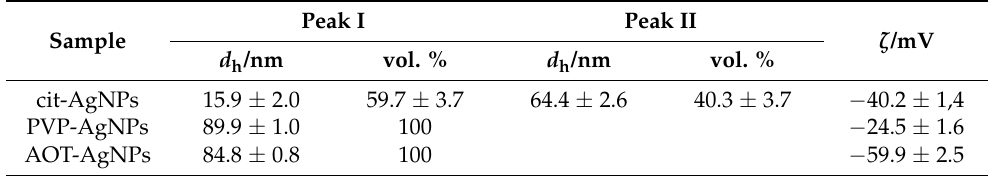
Table 1. The hydrodynamic diameter ( d h ) and zeta potential ( ζ ) of silver nanoparticles (AgNPs), sta- bilized with citrate (cit-AgNPs), poly(vinylpyrrolidone) (PVP-AgNPs), sodium bis(2-ethylhexyl) sul- fosuccinate (AOT-AgNPs) suspended in anionic reactant solution ( c (Na 2 HPO 4 ) = 8 · 10 − 3 mol dm − 3